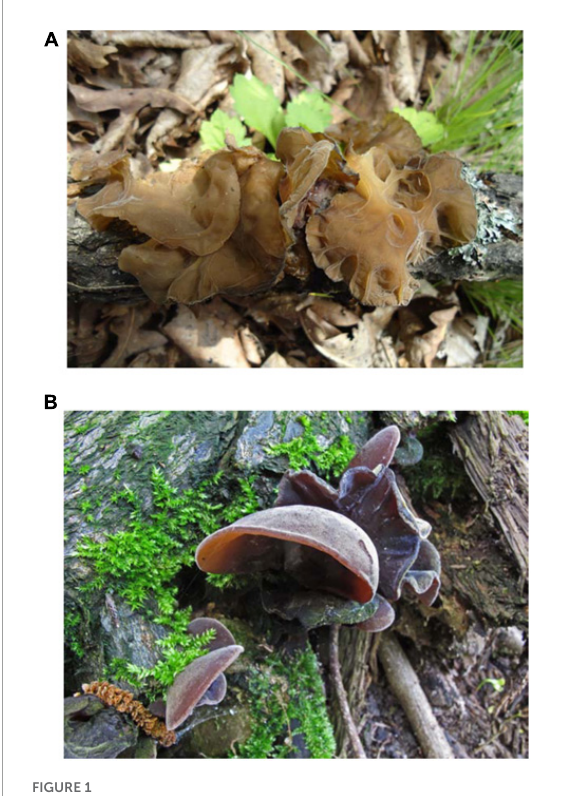
FIGURE1 Basidiocarps of Auricularia heimuer and Auricularia auricula-judae (Wu and Dai, 2015). (A) Basidiocarps of A. heimuer (Dai 13788); (B) Basidiocarps of A. auricula-judae (LYBR